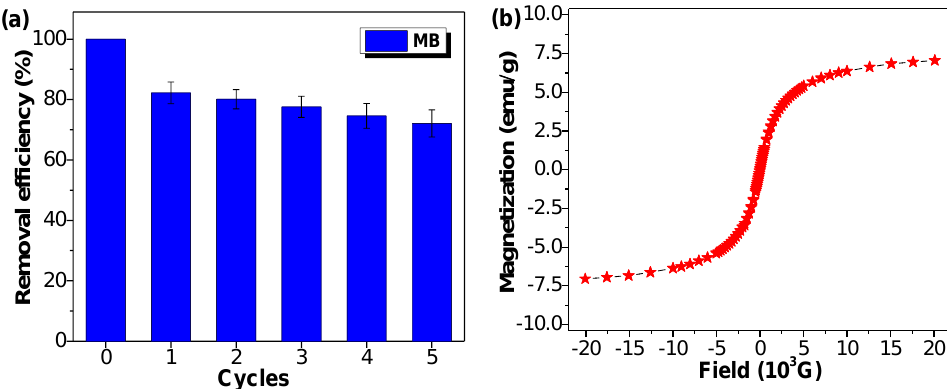
Figure 9. ( a ) Removal efficiency of mPVA/AC CG adsorbent in five successive cycles of desorption- adsorption. ( b ) Magnetization curve (300 K) of mPVA/AC CG adsorbent after reuse for five times.